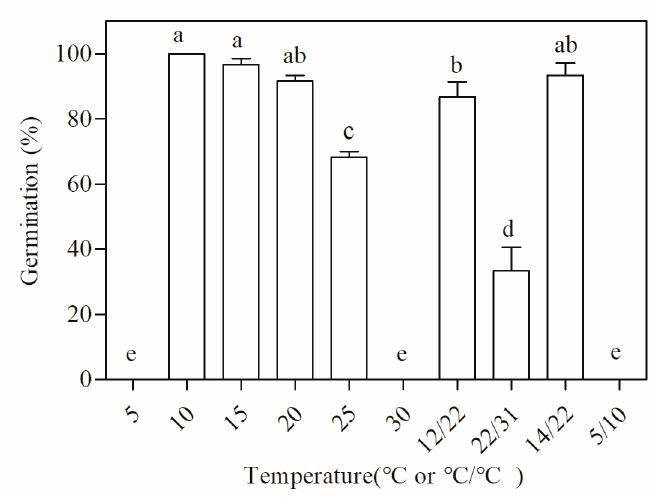
Figure 2. Germination of the isolated embryos at constant and alternating temperatures. Germina- tion was performed at constant temperatures (5, 10, 15, 20, 25, and 30 °C) or alternating temperatures (12/22, 22/31, 14/22, and 5/10 °C) with a 12 h light/12 h dark cycle and PPDF = 121 μ mol·m − 1 ·s − 1 . Each treatment had four replicates and 30 seeds were used for each replicate. There are no significant differences between the data labeled with the same lower case letters ( p = 0.05).